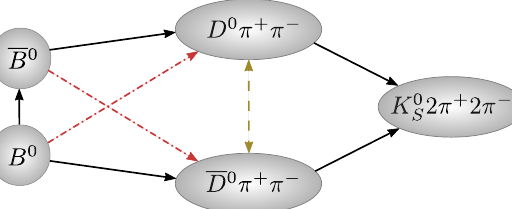
Figure 5 . Transitions scheme of the B 0 denote dominant transitions, red dash-dotted arrows denote suppressed B transitions, brown dashed arrows denote D 0 - D 0